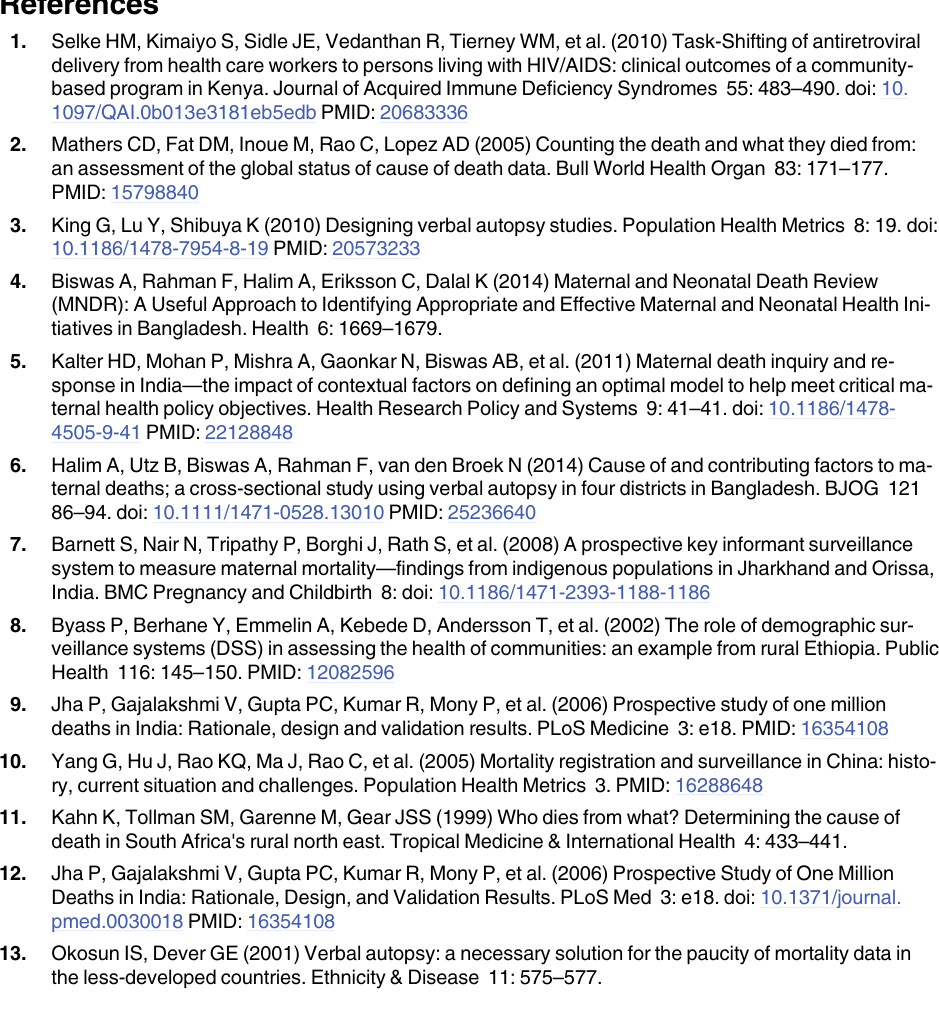
S1 Table. Cost for establishing the Andhra Pradesh Rural Health Initiative mortality sur- veillance system (1st October, 2003- 30th September,